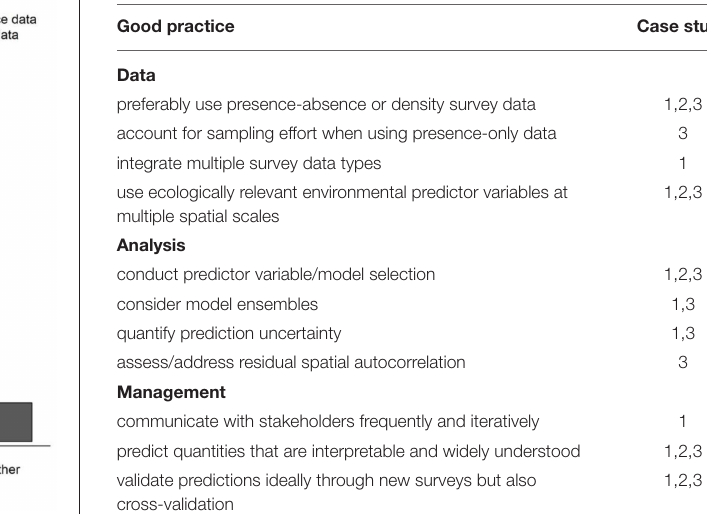
TABLE 1 | Key good practices and illustrative case